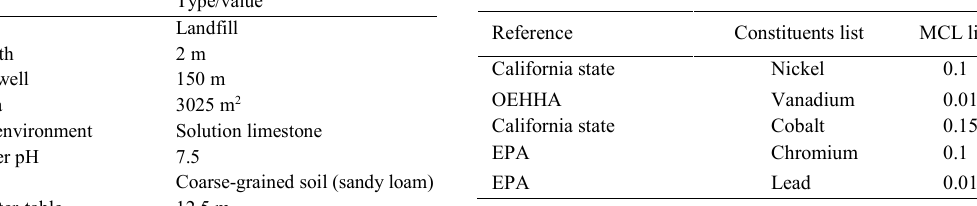
Table 6: Contaminant composition and their maximum contaminant level (Values are expressed as mg/kg)